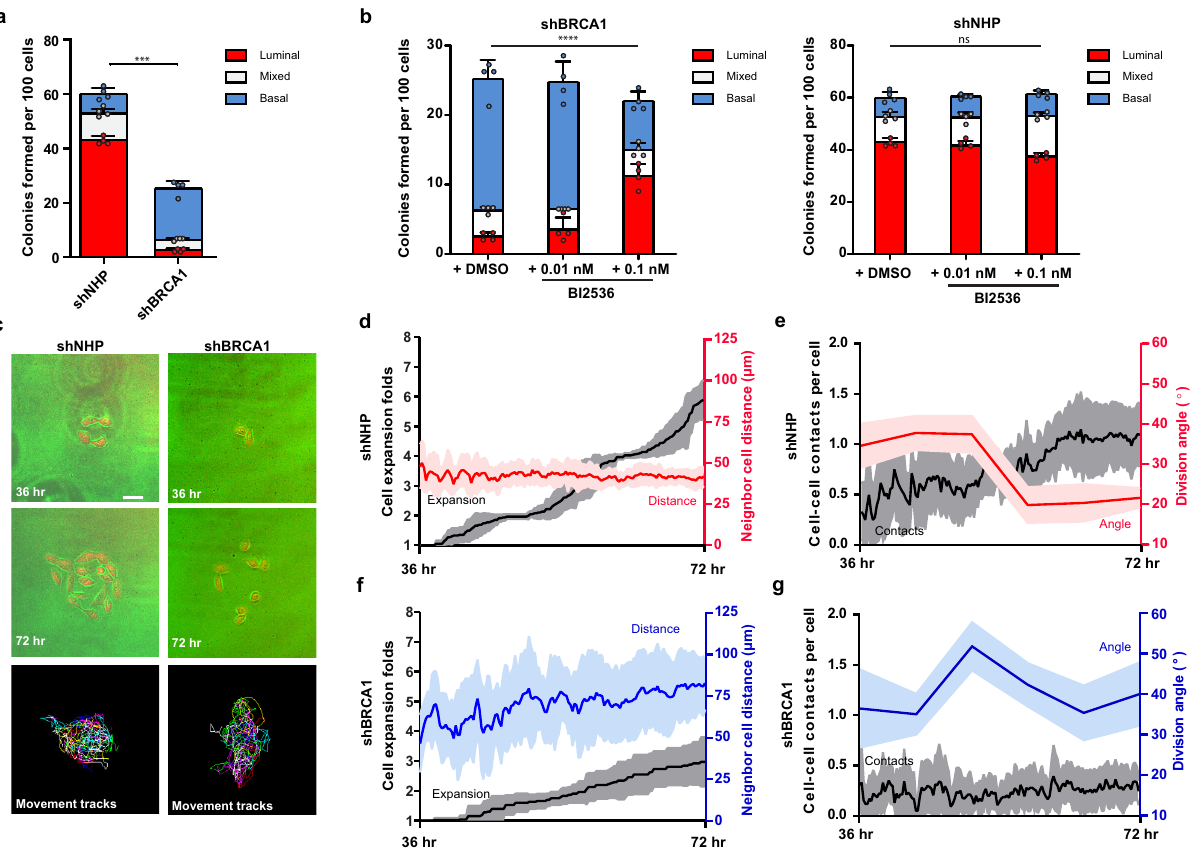
Fig. 6 BRCA1 silencing reduces luminal properties in a PLK1-dependent manner. a Colony structures derived from 100 MCF10A RFP-TUBA1B cells that were transduced either with non-hairpin shRNA (shNHP, hereafter control-transduced) or with BRCA1-targeting shRNA (shBRCA1, hereafter BRCA1- silenced) and classi fi ed at day 5 by the density of nuclei in the colony, as outlined in Supplementary Figure S14 (mean ± SD from four wells across duplicate experiments). *** P = 0.0005; two-tailed unpaired t -test. b Day 5 colony structures derived from 100 BRCA1-silenced (shBRCA1) or 100 control-transduced (shNHP) MCF10A RFP-TUBA1B cells grown in the presence of DMSO or BI2536 (mean ± SD from four wells across duplicate experiments). **** P = 1.09E − 04, ns P = 0.5425; one-way ANOVA. c Colony formation assays for control-transduced (shNHP) or BRCA1-silenced (shBRCA1) MCF10A RFP-TUBA1B cells imaged every 15 min for 36 h. 2 – 4 cell clusters were chosen for imaging at 36 h after seeding. Motion tracking through colony formation is indicated. Scale bar = 50 μ m. d Cell number expansion (black y-axis, LHS) and cell distances measured by Delaunay triangulation (red y-axis, RHS) plotted through the colony formation process for control-transduced (shNHP) MCF10A RFP-TUBA1B cells. Panels d – g plot: mean ± SD band plotted except for division angle mean ± SEM plotted, n = 3 wells imaged per experiment, triplicate experiments. e Cell contacts per cell (black y-axis, LHS) and cell division angles relative to the cell ’ s long axis (red y-axis, RHS) plotted through the colony formation process for control-transduced (shNHP) MCF10A RFP-TUBA1B cells. f Cell number expansion (black y-axis, LHS) and cell distances measured by delaunay triangulation (blue y-axis, RHS) plotted through the colony formation process for BRCA1-silenced (shBRCA1) MCF10A RFP-TUBA1B cells. g Cell contacts per cell (black y-axis, LHS) and cell division angles relative to the cell ’ s long axis (blue y-axis, RHS) plotted through the colony formation process for BRCA1-silenced (shBRCA1) MCF10A RFP-TUBA1B